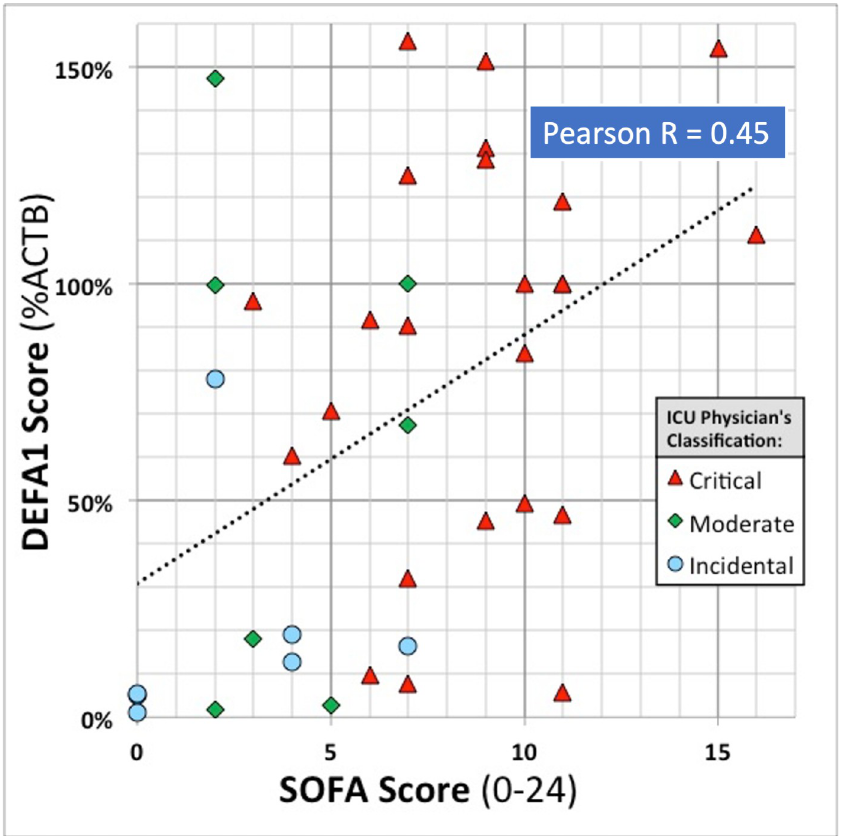
Fig 4. Whole blood DEFA1 RNA vs SOFA score of COVID-19 severity. Blood RNA from COVID-19 patients in the ICU (n = 38) was quantified for DEFA1 mRNA level by ddPCR and expressed as a percent of the ACTB mRNA level in the fixed RNA sample amount per patient (200 ng) thus minimizing changes in the abundance of neutrophils in blood between patients. The DEFA1 level (Y axis, as %ACTB) is plotted against the SOFA score determined clinically in the ICU according to the number and of degree of organ distress in the patient. Each point reflects a patient, colored according to their clinical classification. Dashed line indicates a linear fit to the data. R = Pearson’s correlation between SOFA and